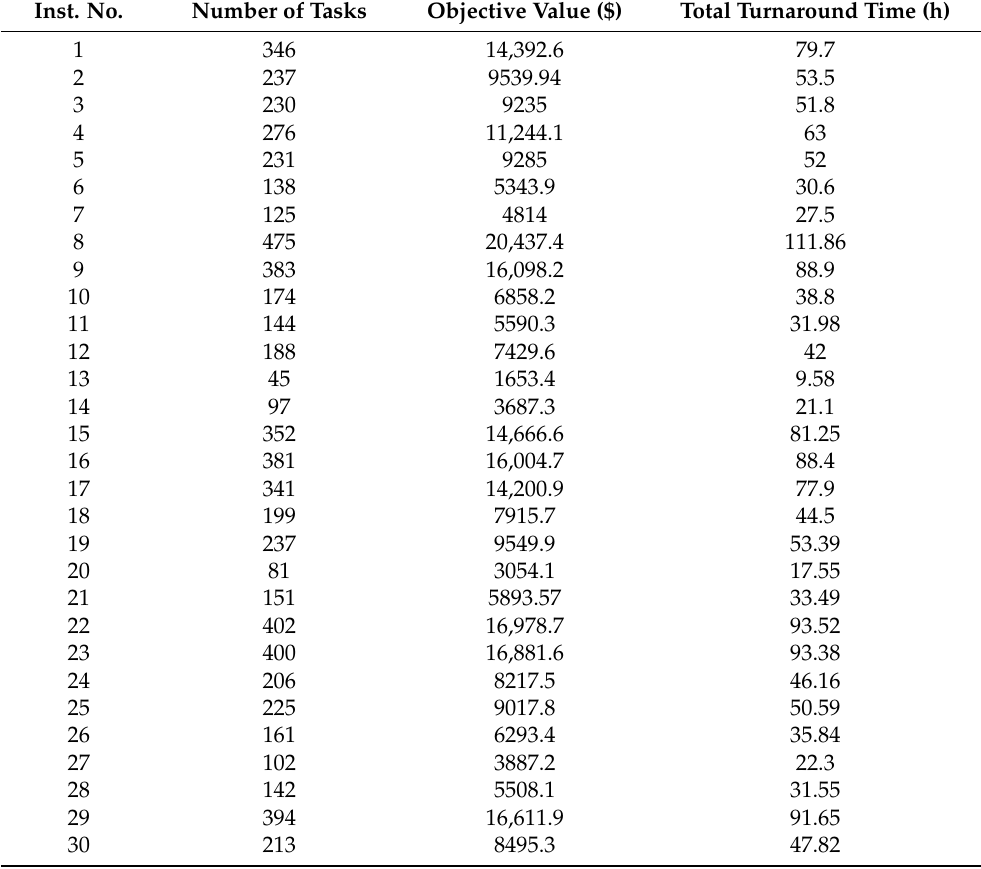
Table 10. The obtained results for 30 instances. Inst.